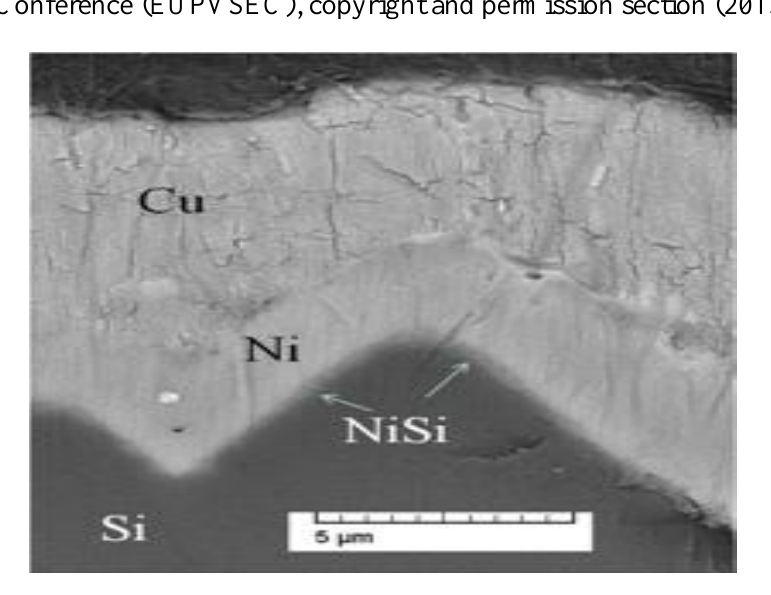
Figure 9. SEM cross sectional image of a mechanically polished NiSi/Ni/Cu stacks on textured silicon presented by Nguyen et al. , with permission from European Photovoltaic Solar Energy Conference (EUPVSEC), copyright and permission section (2013)